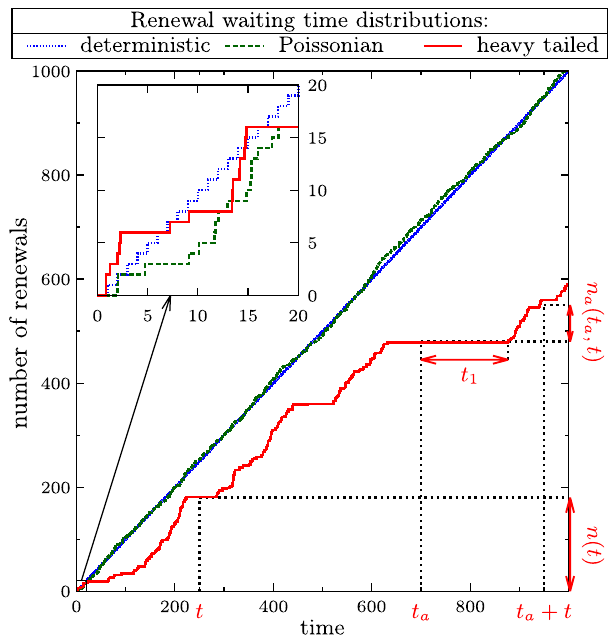
FIG. 1 (color online). Sample realizations for three different types of renewal processes. Events are separated by waiting times, which are independent, identically distributed according to a probability density function (PDF) ψ ð t Þ . Here, we depict the cases of deterministic periodic renewals, ψ ð t Þ ¼ δ ð t − 1 Þ , Poissonian waiting times, ψ ð t Þ ¼ e − t , and heavy-tailed waiting times, ψ ð t Þ ¼ 4 . 5 × ð 5 t þ 1 Þ − 1 . 5 (see